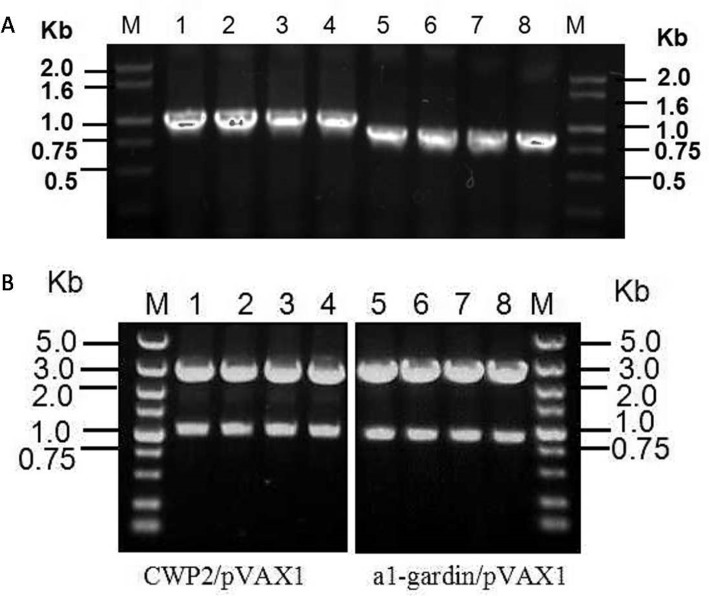
Identification of the α1-giardin and CWP2 insert in isolated plasmids.Toal 4 colonies were randomly picked from plates without kanamycin spread with SL7207/pVAX1-CWP2 (lane 1–4) and SL7207/ pVAX1- α1-giardin (lane 5–8) after being cultured in a kanamycin-free media for 168 hours. The corrected DNA inserts in the extracted plasmid DNAs were confirmed by PCR amplified with vector flanking primers T7 and BGH (A) and by restriction digestion with HimdIII and BamHI (B). M. DNA maker.